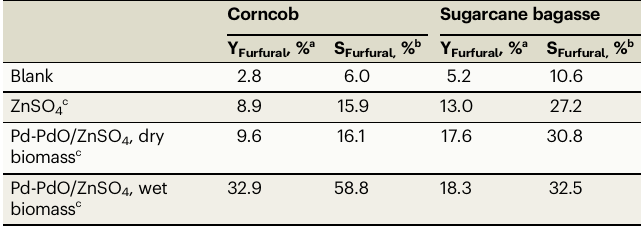
Table 2 | Product distribution from the pyrolysis of corncob and sugarcane bagasse with and without catalysts in Pyro- probe at 400 °C Corncob Sugarcane